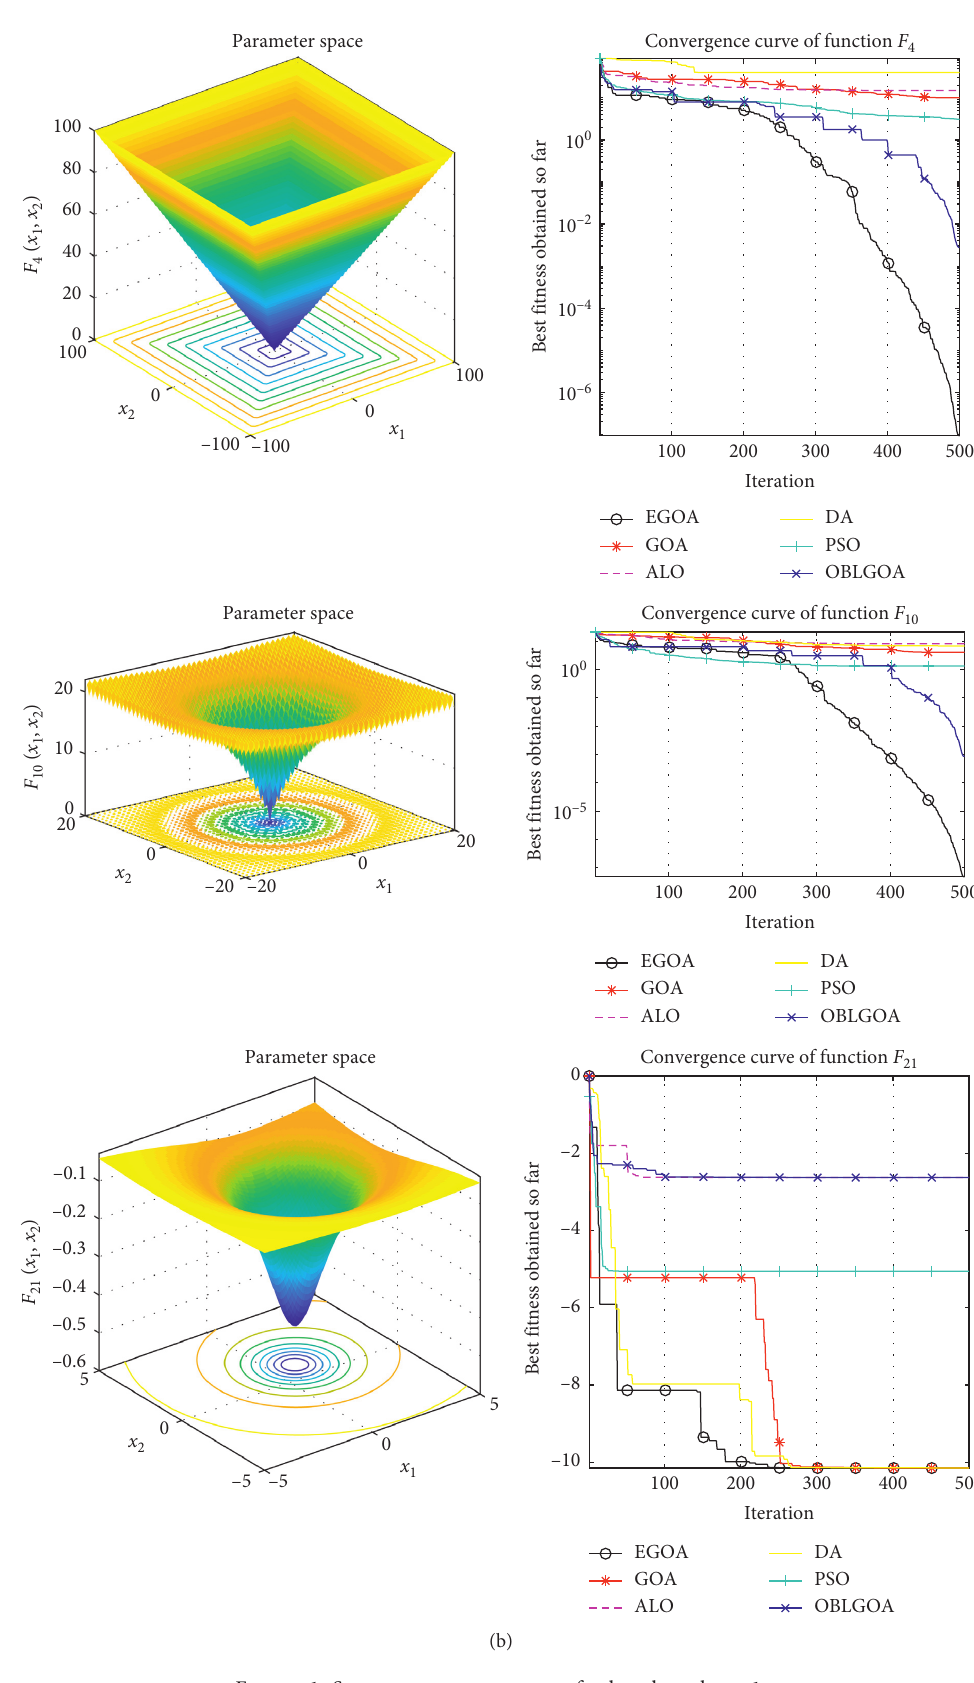
Figure 1: Some convergence curves for benchmark set